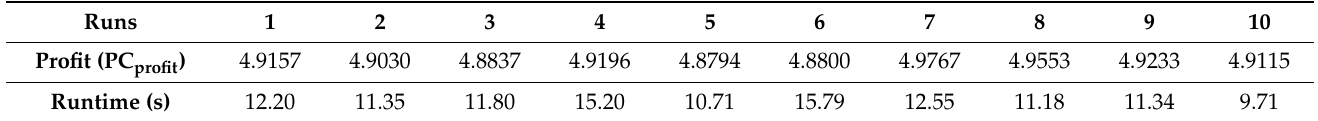
Table 6. Profit and runtime during different executions for instance type 1.